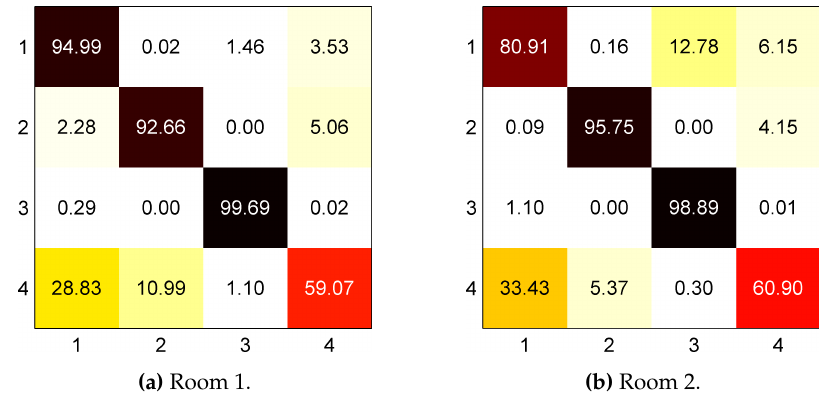
Figure 7. Confusion matrix for data of ( a ) Room 1 and ( b ) Room 2. Output of dynamically weighted conditional random field (dWCRF) classifier for labels 1: Sitting-on-bed, 2: Sitting-on-chair, 3: Lying and 4: Ambulating. Results in